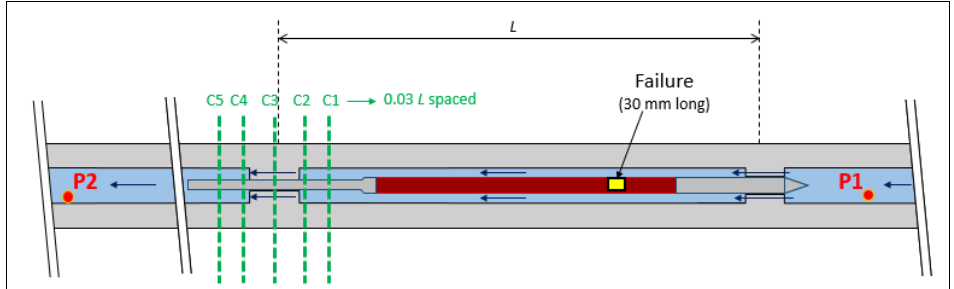
Figure 12. Positions of pressure history extraction positions around the outlet